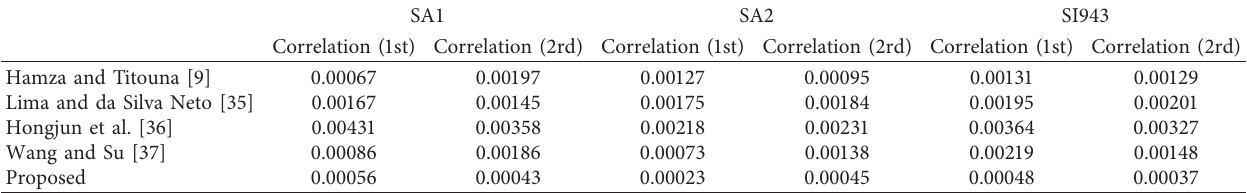
Table 4: Similarity coefficients between source speech signal and observed signal.